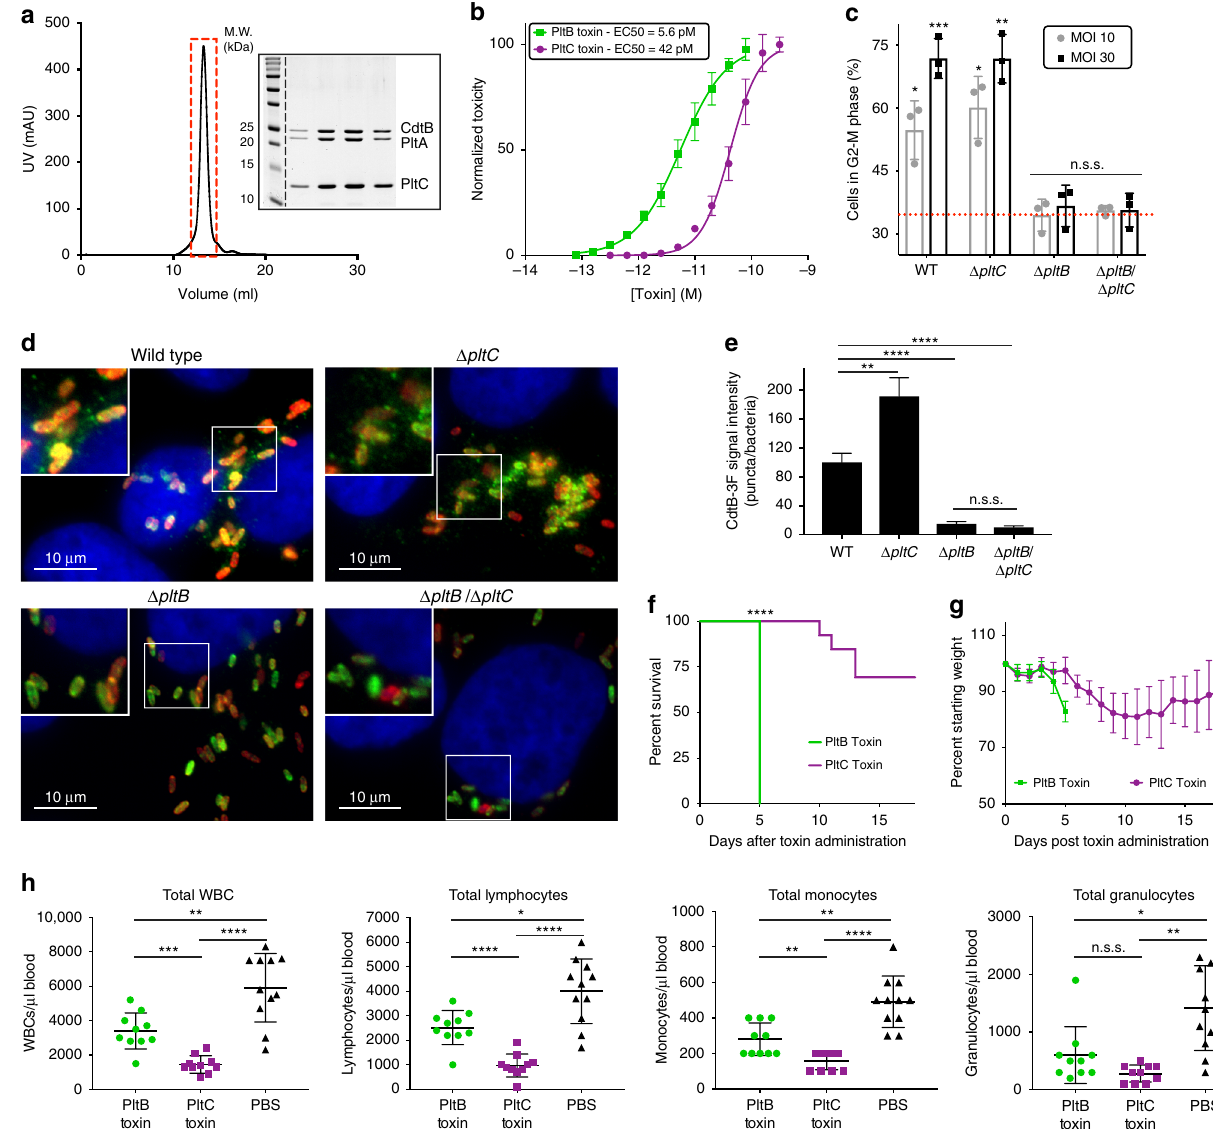
Fig. 2 The PltB- and PltC-typhoid toxins exhibit different biological properties. a Gel fi ltration chromatography and SDS-PAGE/Coomassie blue (inset) analyses of puri fi ed PltC-typhoid toxin. Lanes on gel represent individual chromatographic fractions (red box) containing puri fi ed toxin. b PltC- typhoid toxin elicits G2/M cell cycle arrest in human epithelial cells. Puri fi ed PltB- or PltC-typhoid toxins were added to the culture medium of Henle-407 cells at the indicated concentrations and 48h after, cells were fi xed and analyzed by fl ow cytometry to evaluate toxicity as indicated in Materials and Methods. The data shown are the mean normalized toxicity± S.D. for three independent experiments. c PltC-typhoid toxin does not induce G2/M arrest in S . Typhi-infected cells. Henle-407 cells were infected with the indicated strains at a multiplicity of infection (MOI) of 10 or 30, as indicated, and 48h post- infection cells were collected and the percentage of cells in G2/M phase was determined as described for panel b . Mean values±S.D. are shown for three independent experiments assayed in duplicate (6 total samples). Asterisks denote statistically signi fi cant levels G2/M cell cycle arrest compared to mock infected cells (red dotted line) as determined by unpaired two-tailed t -tests. d , e PltC-typhoid toxin is not packaged into vesicle transport carriers. Henle- 407 cells were infected with the indicated S . Typhi strains encoding 3x-FLAG epitope-tagged CdtB and 48 hs post-infection the cells were fi xed and stained with DAPI (blue), α -FLAG (green), and α - S . Typhi LPS (red) antibodies. Typhoid toxin-containing export vesicles, which appear as green puncta d , were quanti fi ed by image analysis e as indicated in Materials and methods. Values are from >25 images (~100 infected cells) taken in two independent experiments and represent the mean relative ratios ± S.E.M. Asterisks denote the statistical signi fi cance of the indicated pairwise comparisons determined using unpaired two-tailed t -tests. f – h The PltB- and PltC-typhoid toxins elicit different effects when administered to mice. Highly puri fi ed preparations of PltB- (2 μ g) or PltC-typhoid toxins (10 μ g) were administered to C57BL/6 mice. For one group of mice, their survival f and body weight (mean ± S.D.) g was recorded at the indicated times. The remaining mice were killed at four days post-toxin administration and a blood sample was collected and analyzed to quantify the indicated cell types (mean ± S.D.) h . WBCs, white blood cells. The Mantel-Cox test was used for statistical analysis of mouse survival and Brown-Forsythe and Welch ANOVA coupled with Dunnett ’ s T3 multiple comparisons tests were used to statistically compare the indicated samples for the blood analysis. For all panels, **** p < 0.0001, *** p < 0.001, ** p < 0.01, * p < 0.05, n.s.s. not statistically signi fi cant. Source data are provided as a